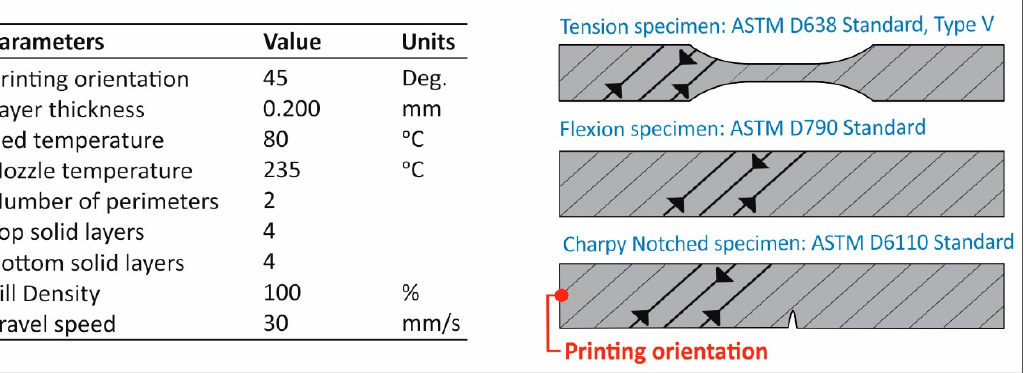
Figure 2. Flow chart with the methodology followed for the PA12 recycling in the current study.